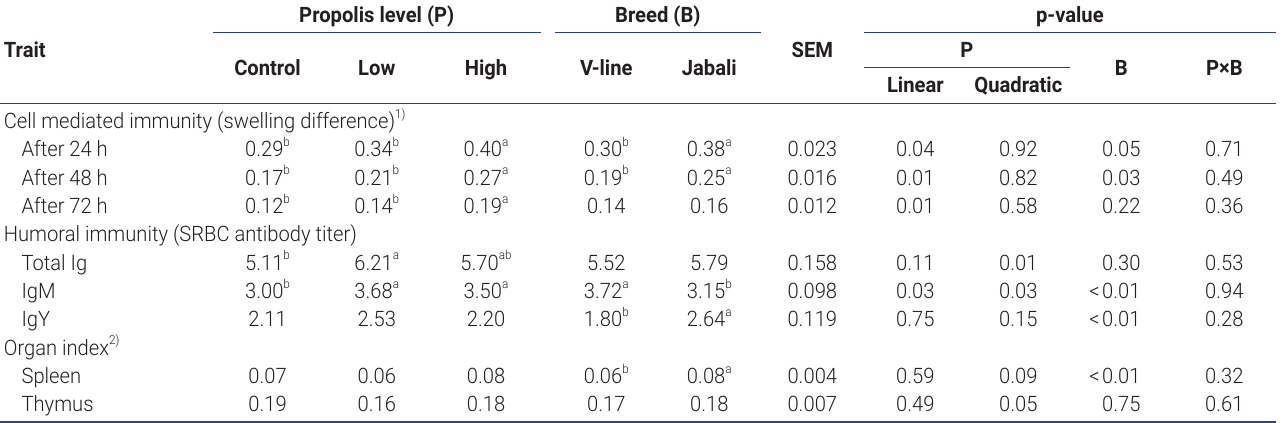
Table 2. Effect of propolis level and breed on immune response and lymphoid organ index of growing rabbits